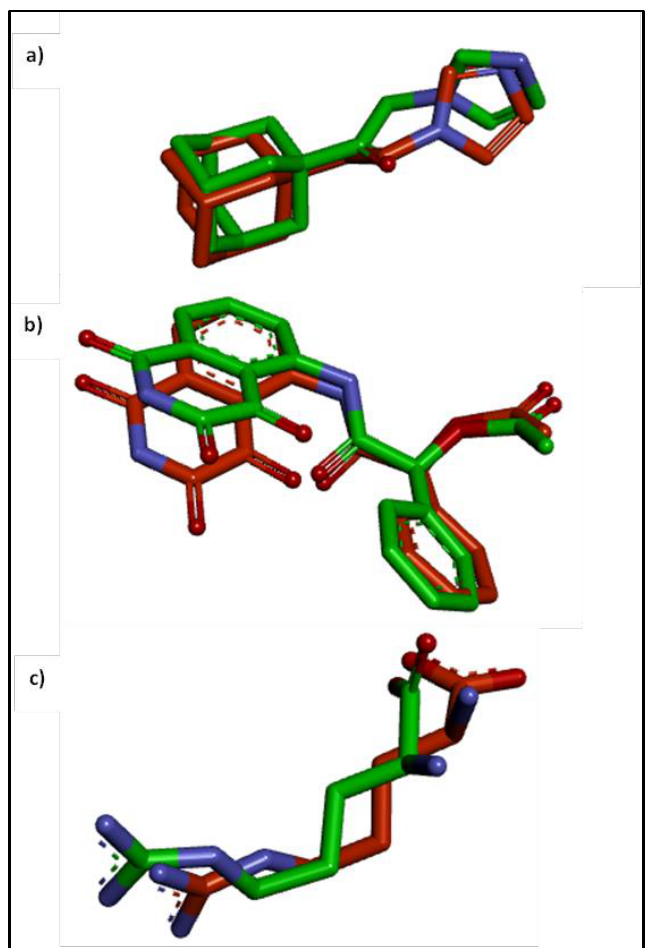
Figure 16. Overlay of the docked and co-crystalized ligand of ( a ) HO-1 (RMSD = 1 Å), ( b ) caspase-3 (RMSD = 1.118 Å), and ( c ) inducible nitric oxide synthase (RMSD = 1.496 Å)